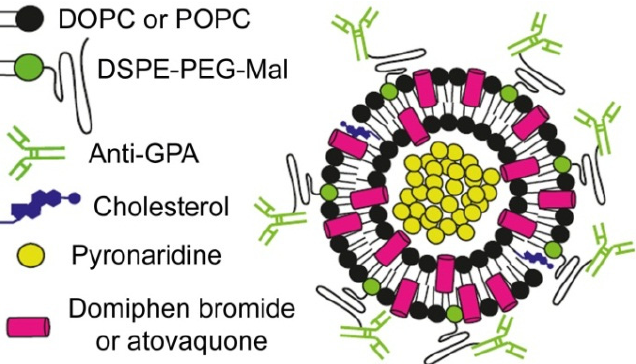
Figure 5. Scheme of an immunoliposome designed for targeted antimalarial combination therapy. DOPC: 1,2-dioleoyl- sn -glycero-3-phosphocholine; POPC: 1-palmitoyl-2-oleoyl- sn -glycero-3- phosphocholine; DSPE: 1,2-distearoyl- sn -glycero-3-phosphorylethanolamine; Mal: maleimide; GPA: glycophorin A. Reproduced with permission from [172], MDPI, 2019.